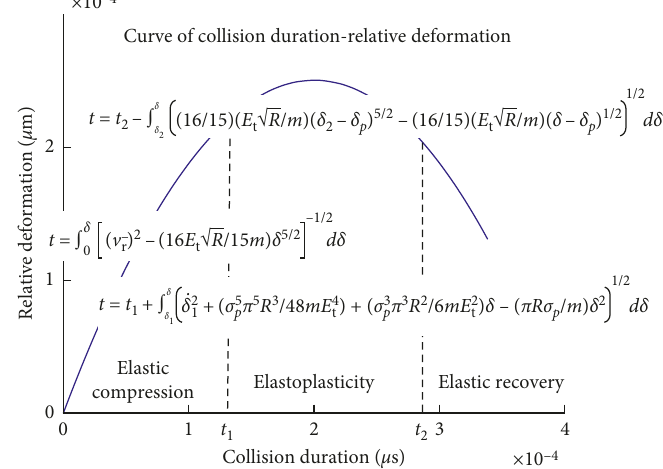
Figure 2: Curve of collision duration-relative deformation of three phases.